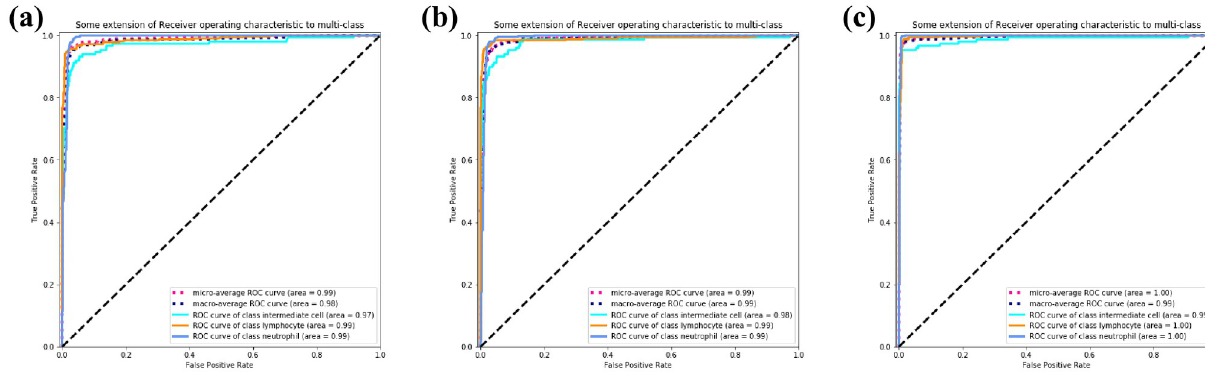
Fig 9. ROC curve. (a) MobileNetV2. (b) ResNet. (c)